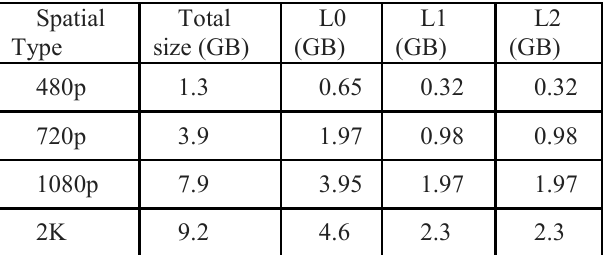
Figure 8. Download time comparison, "MediaStratify" vs SVC for contents in [4]